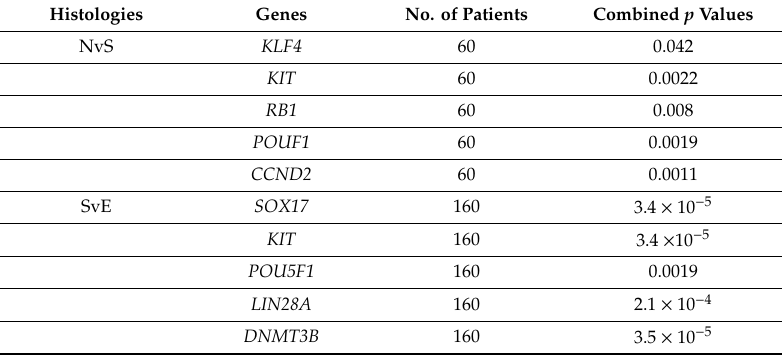
Table 2. RNA expressions of genes that separate the histologic